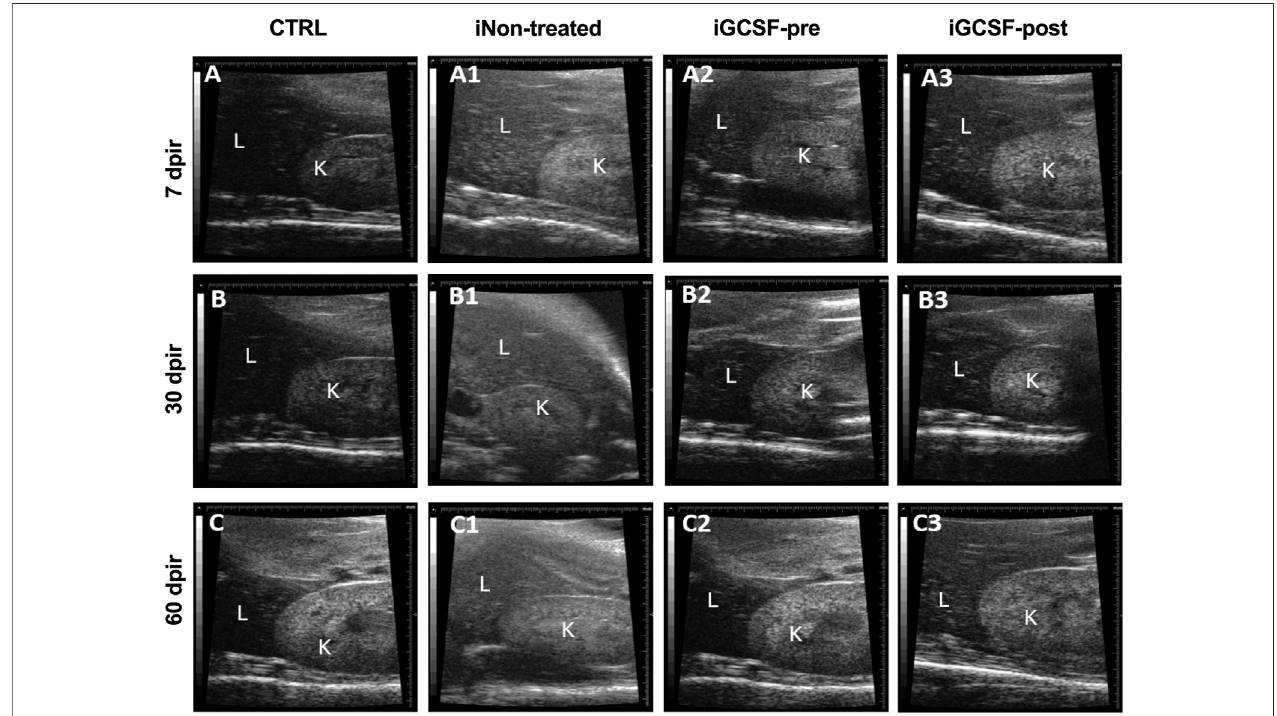
FIGURE 3 | Hepatorenal ultrasound fi ndings. Ultrasound images obtained from CTRL (A – C) , iNon-treated (A1 – C1) , iGCSF-pre (A2 – C2) and, iGCSF-post group (A3 – C3) at 7, 30- and 60-day post-irradiation. Images obtained from CTRL group (A – C) and iGCSF-pre Group (A2 – C2) showed that the liver (L) was less echogenic than the kidney (K). Echogenicity similarities between liver and kidney were observed in 7 dpir (A1) . Changes in hepatorenal echogenicity were observed in 60 dpir in iGCSF-post, where the liver was hyperechogenic concerning the renal parenchyma ( n (cid:1) 8 per Group).